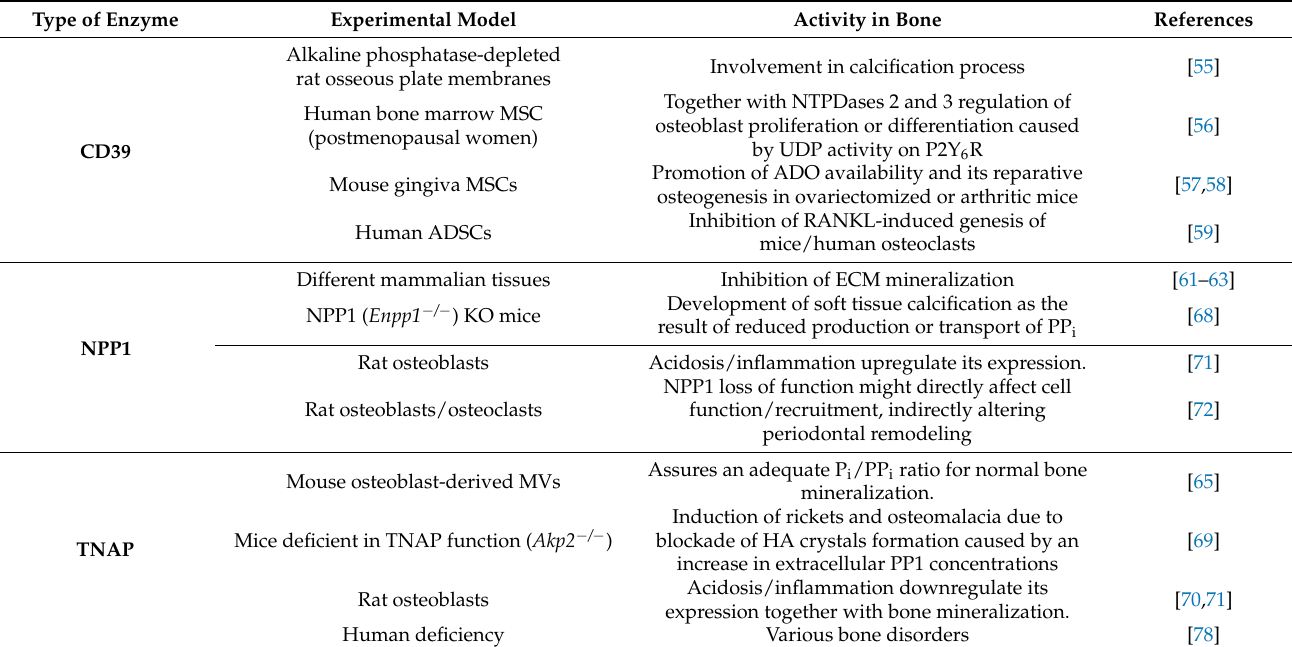
Table 1. Role of extracellular purine degrading enzymes in bone